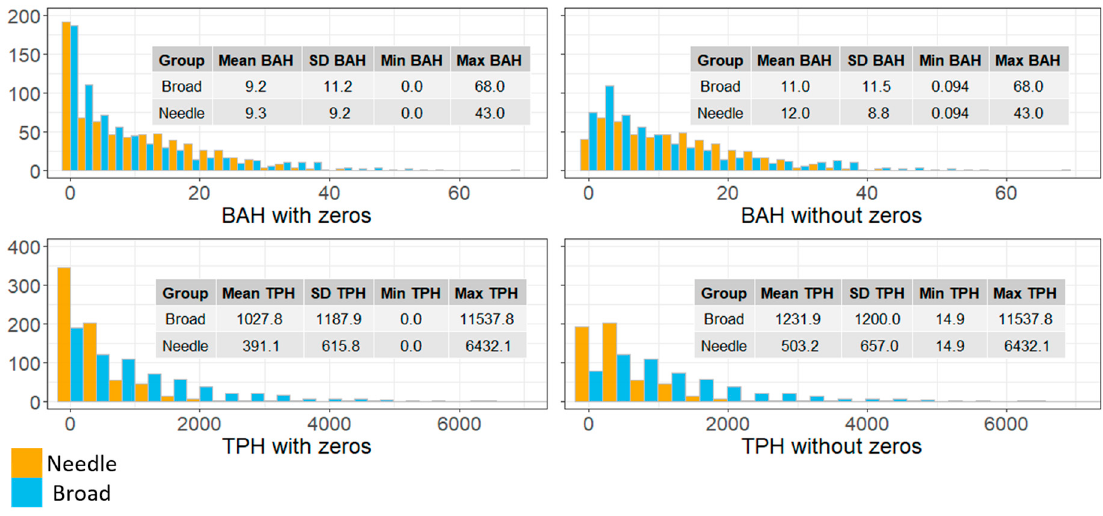
Figure 4. Histograms and summary statistics of Forest Inventory and Analysis (FIA) plots for basal area per hectare (BAH) and trees per hectare (TPH) of needle-leaf (orange) and broadleaf (blue) species groups with and without zeros.